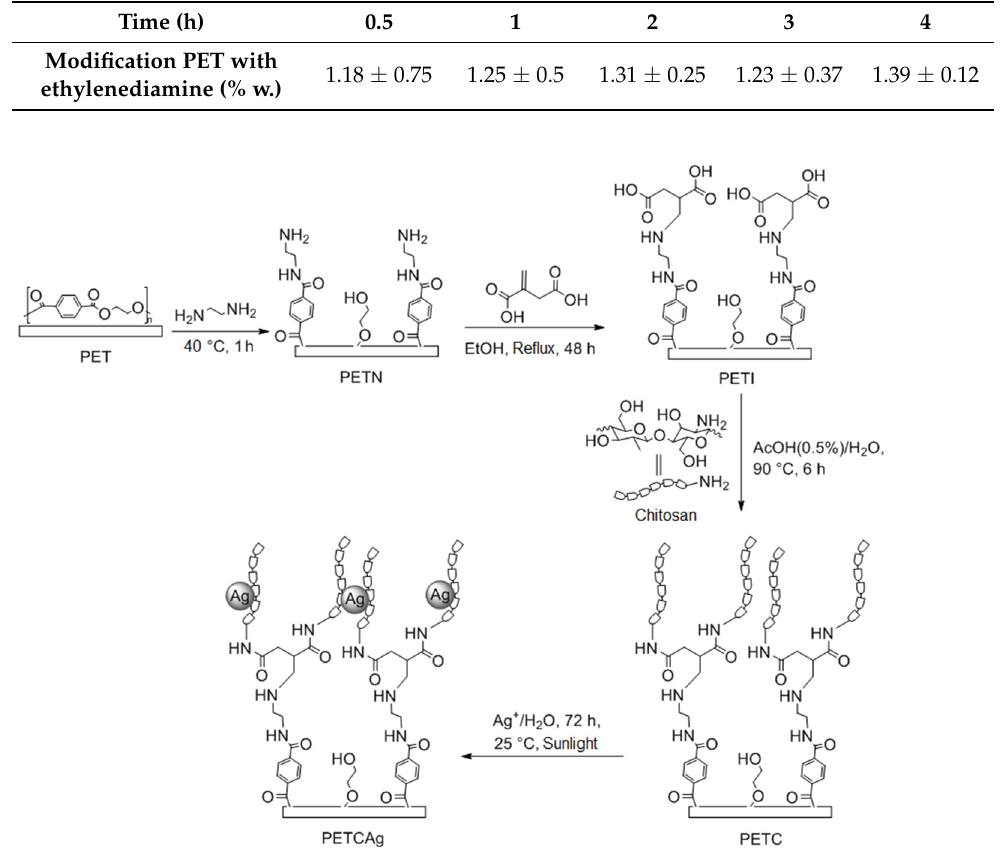
Figure 2. Scheme of chitosan graft on the functionalized PET